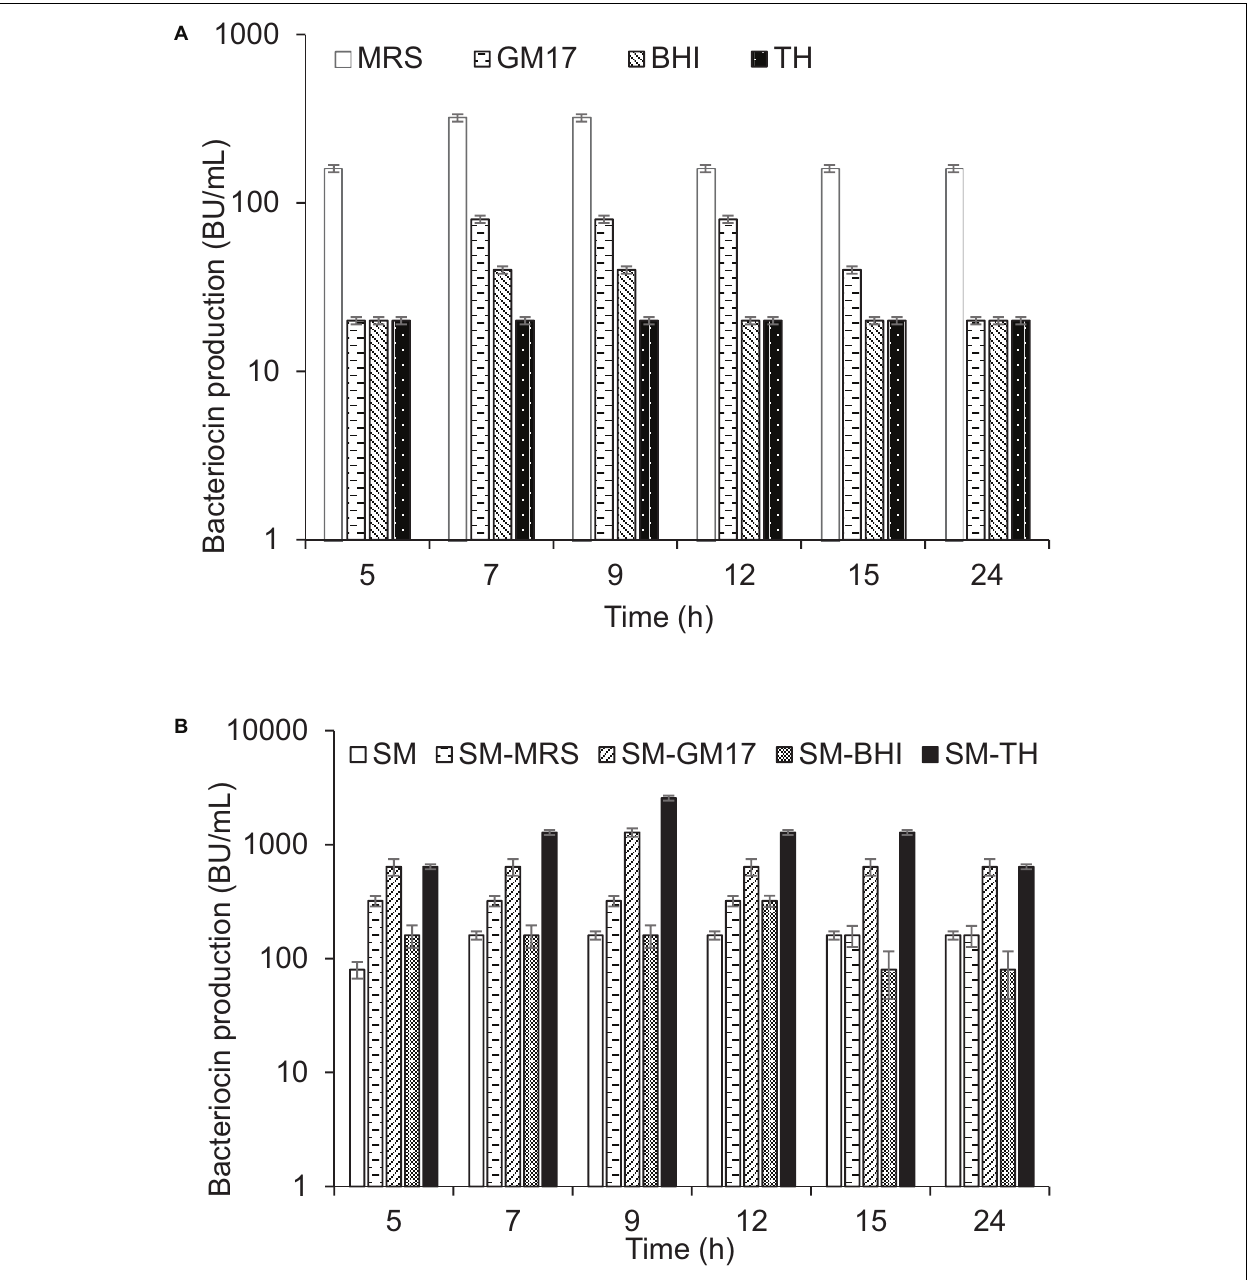
FIGURE 1 | GarKS production by the native producer in different complex growth media (A) , and in skim milk (SM) combined with complex growth media (B) . Each culture was started by adding 1% (v/v) culture inoculum to 5 ml growth medium and then incubated at 30 ◦ C without shaking. Bacteriocin activity was measured at different time points. Standard deviations were based on triplicate